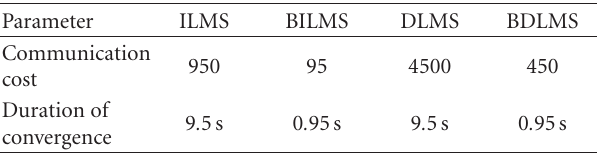
Table 2: Numerical comparison of performances of sequential and block distributed adaptive